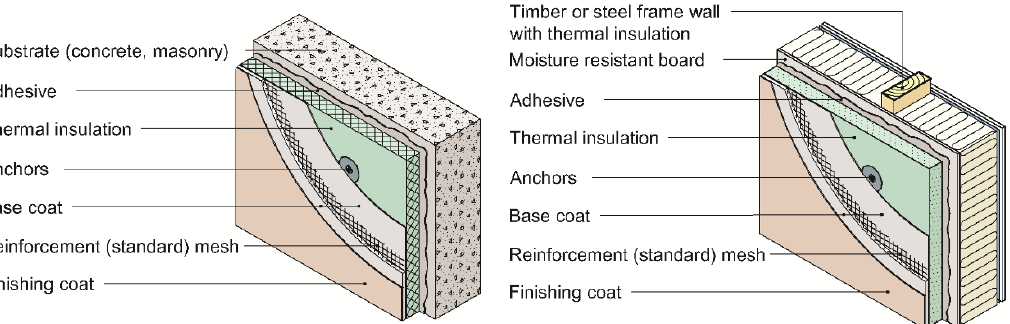
Figure 1. Typical composition of a modern façade system using External Thermal Insulation Composite Systems (ETICS) on masonry or concrete wall ( left ) and light wooden framework wall ( right ).